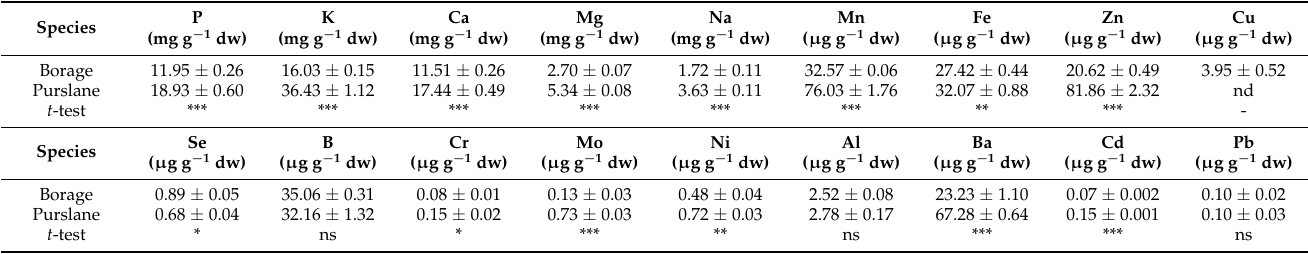
Table 2. Mineral composition of the microgreens growing in controlled conditions. Means were statistically separated using a two-tailed Student’s t -test. ns: Not significant; *: p < 0.05; **: p < 0.01; ***: p < 0.001; nd: Not detected. Species Borage